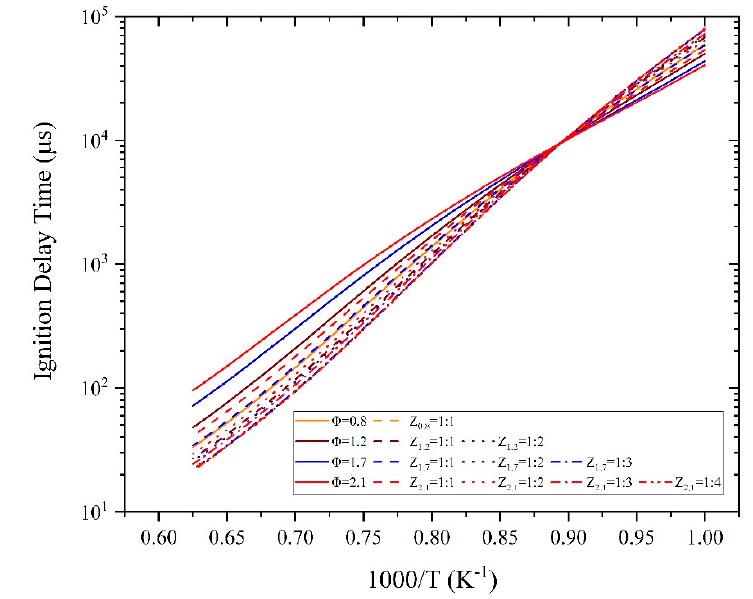
Figure 6. Comprehensive comparison of the ignition delay times of air–light hydrocarbon mixing gas at different mixing degrees and n -pentane at equivalence ratios of 0.8, 1.2, 1.7, and 2.1, respectively.